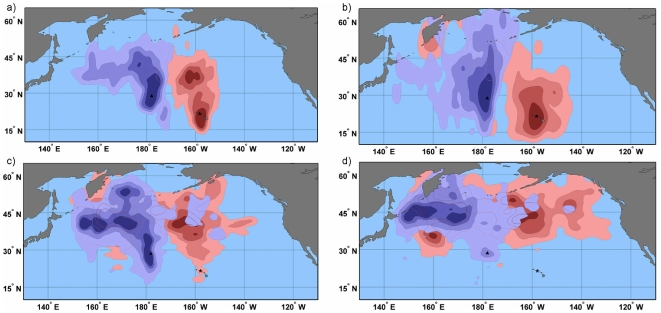
Overlap of kernel density estimates for Laysan albatross foraging from Kure and Oahu during phases of the reproductive cycle.Red tones represent Kure Atoll, blue represent Oahu and contour lines represent the 95%, 75%, 50%, and 25% kernel estimates during the a) incubation b) chick guard c) post-guard and d) non-breeding stages. Kure colony location is indicated by a triangle, and Oahu colony location is indicated by an asterisk.